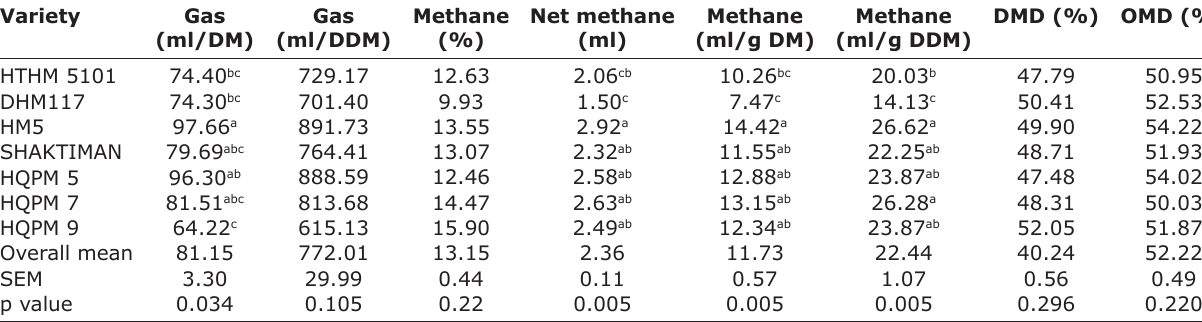
HQPM 9 DM=Dry matter, OM=Organic matter, TA=Total ash, CP=Crude protein, EE=Ether extract, NFE=Nitrogen free extract, CF=Crude fiber, HQPM=High-quality protein maize Table-2: In vitro fermentation of different varieties of maize green fodder.